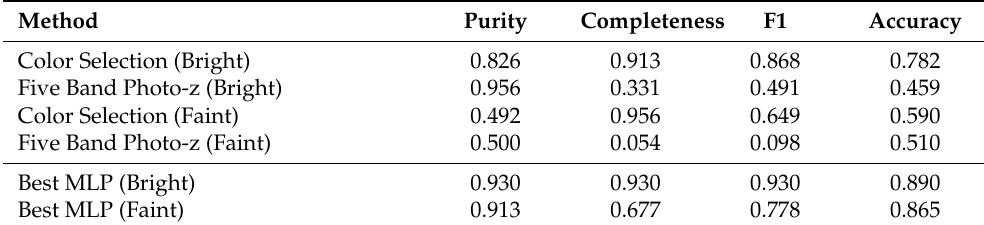
Table 4. Comparisons of various non-spectroscopic methods for various magnitudes. Bright galaxies are those with i magnitude between 14 and 20, while Faint galaxies are those with i magnitude between 20 and 27. Here, all methods are tested for the region r ≤ 1.5